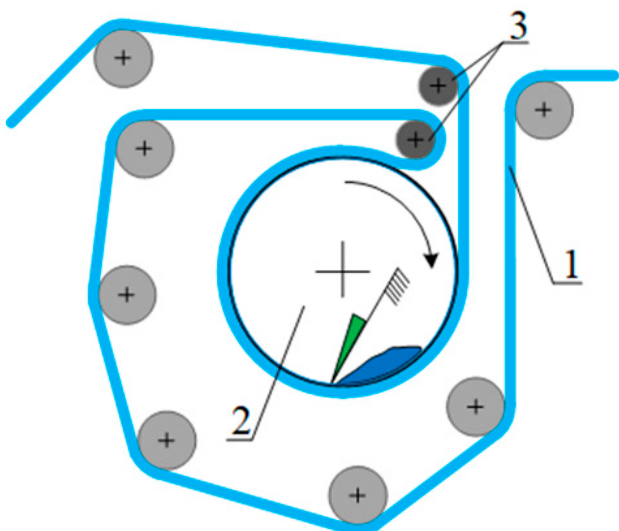
Figure 9. Diagram of a section of a screen printing machine with additional rollers pressing the film to the surface of a rotary printing plate with an increased diameter. 1—shrink film (shell) with shape memory, 2—printed form (metal mesh), 3—pushing rolls.